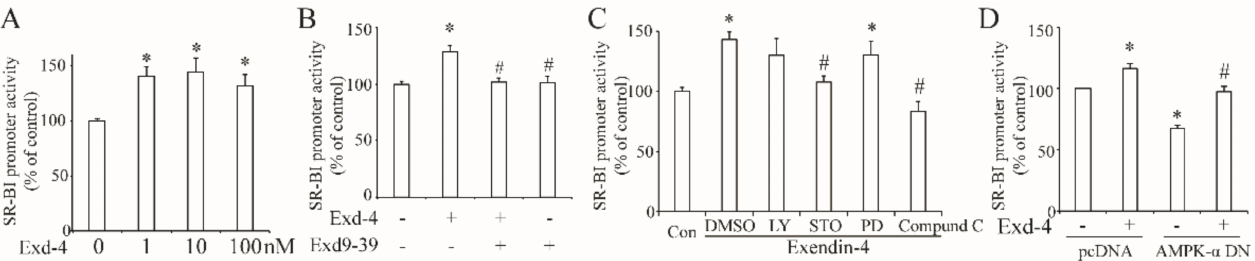
Figure 3. Exendin-4 enhanced the transcriptional activity of hSR-BI/CLA-1 via AMPK signaling pathway in HUVECs . ( A ) The promoter activity of hSR-BI/CLA-1 induced by varying doses of exendin-4 (0~100 nM) for 24 h. ( B ) The promoter activity of hSR-BI/CLA-1 in HUVECs with the treatment of exendin-4 or exendin9-39 for 24 h. ( C ) The effect of LY294002, STO-609, PD98059 or Compound C on the promoter activity of hSR-BI/CLA-1 induced by exendin-4. ( D ) The effect of dominant–negative AMPK catalytic α 1 subunit on the promoter activity of hSR-BI/CLA-1 induced by exendin-4. * p < 0.05 compared with control; # p < 0.05 compared with